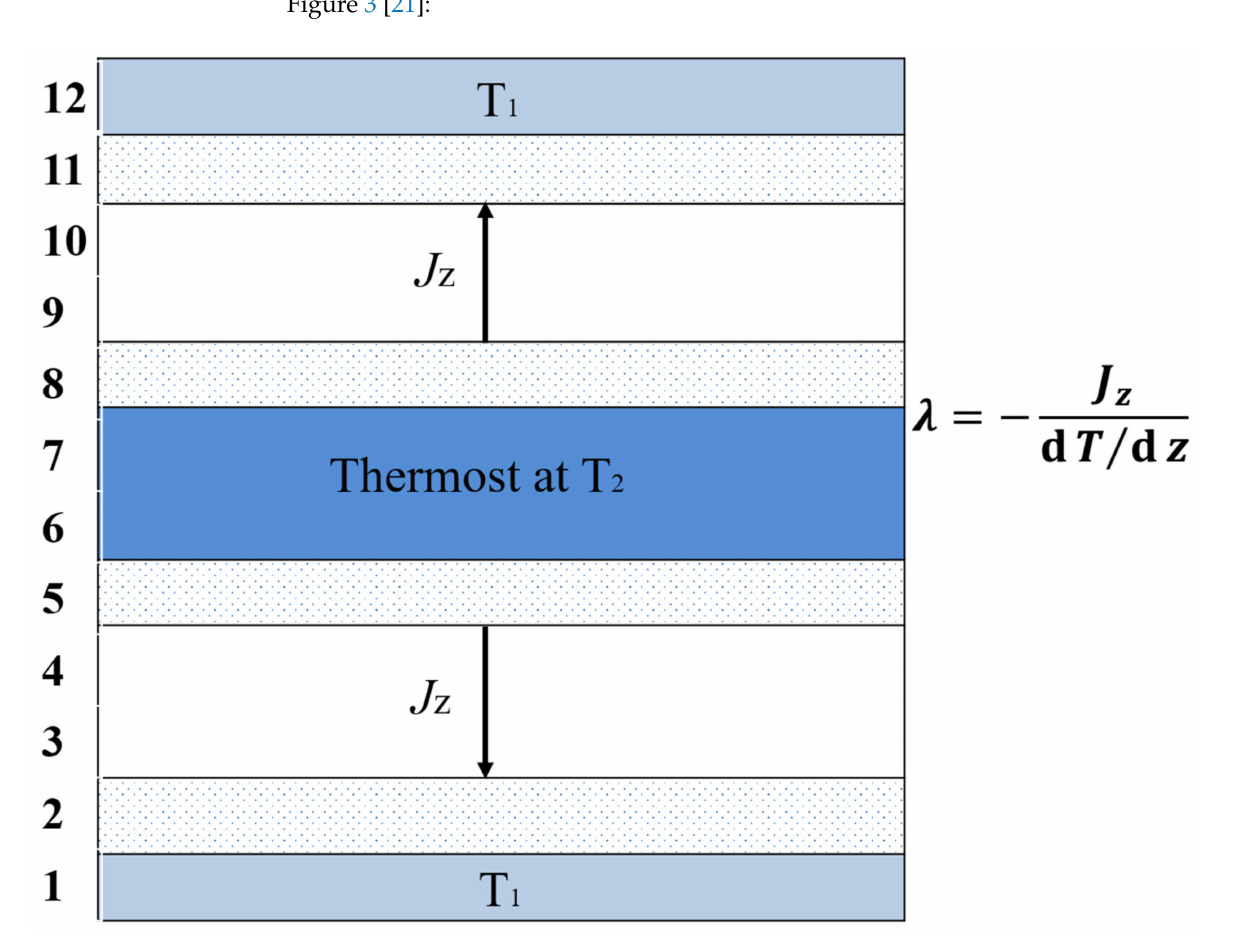
Figure 3. Schematic diagram of calculation of thermal